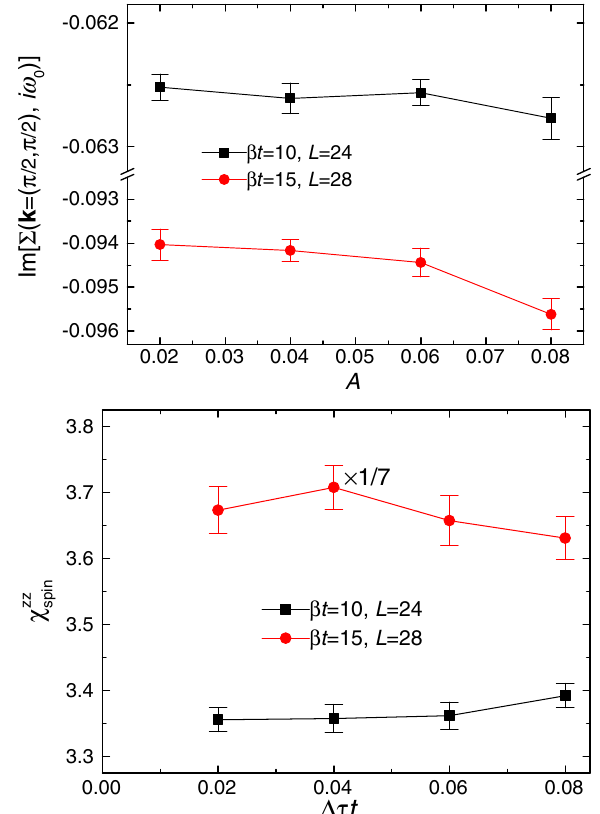
FIG. 33. DQMC: Trotter extrapolation for the lowest Matsu- bara frequency of the imaginary part of the self-energy at the node (upper panel) and the magnetic susceptibility at the antiferro- magnetic wave vector (lower